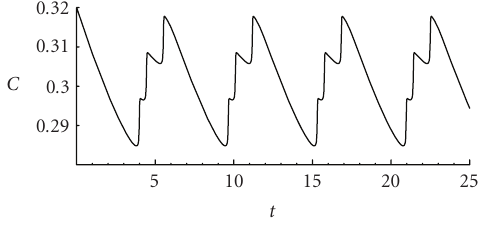
Figure 2.9. Time sequence of calcium concentrations for g K , C = 15 . 0 s − 1 .